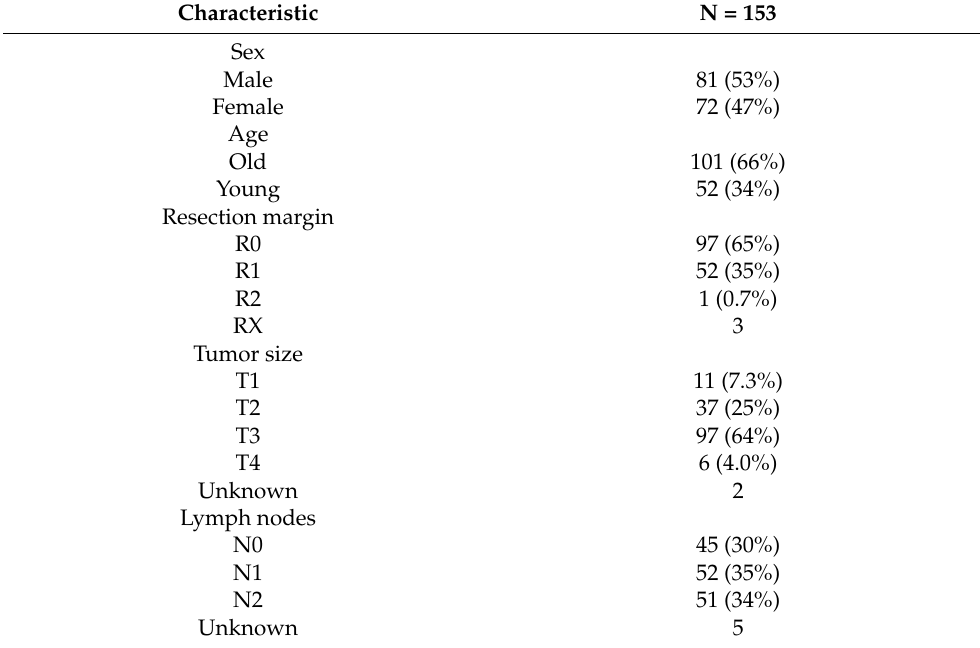
Table 1. Baseline characteristics, histopathological findings, and pattern of first recurrence of the patients of the PANCALYZE study